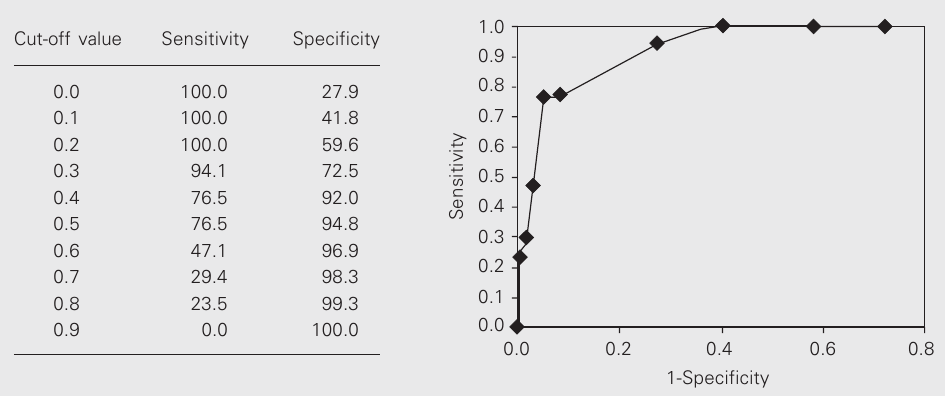
Figure 2. The receiver operating characteristic